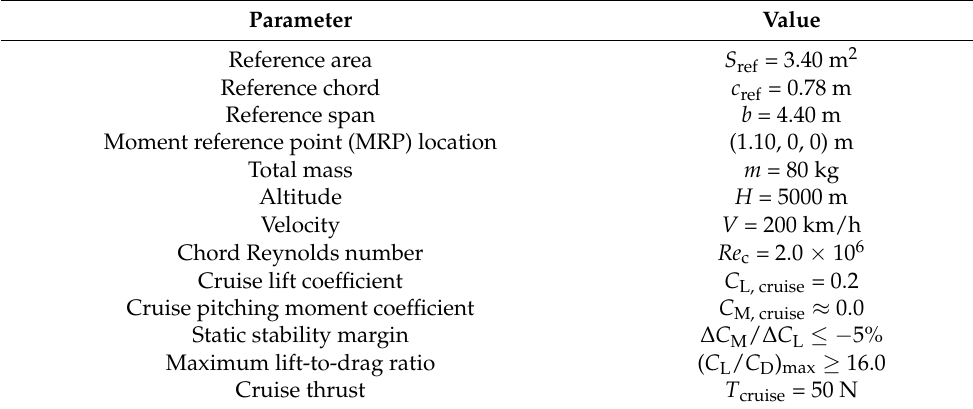
Table 1. Reference dimensions, flight conditions, and cruise targets of the present DEP-based BWB UAV.